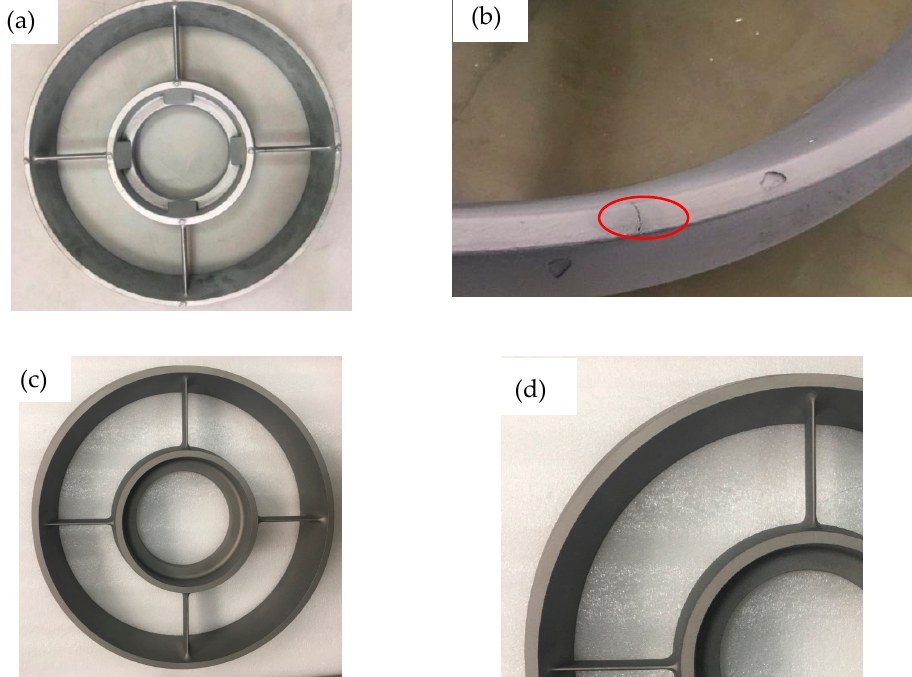
Figure 6. The pictures of TiAl cases. Using a 4 × cross runner, misrun defects were found in the area corresponding to the middle of the two runners on the upper edge of the outer ring in ( a , b ). Using an 8 × cross runner, no misrun defect was found on the upper edge of the outer ring in ( c , d ).